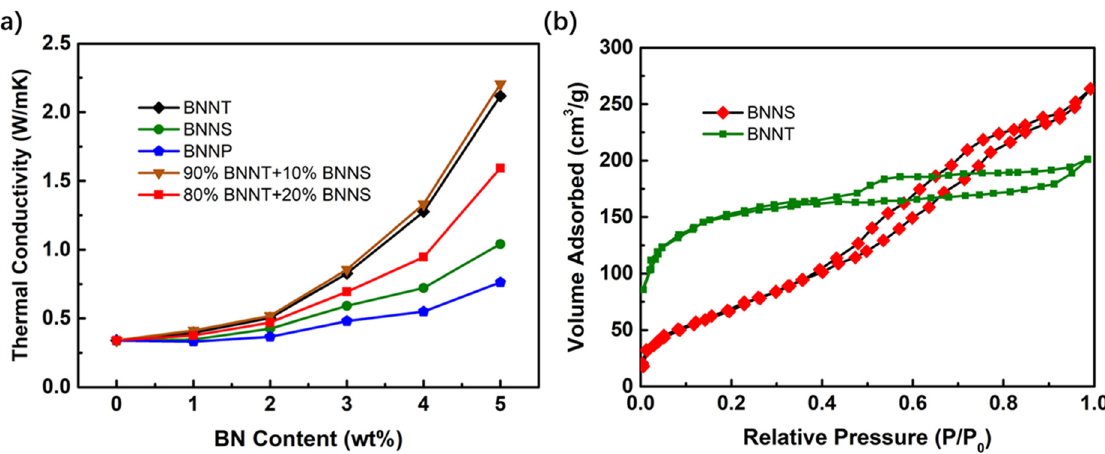
Figure 9. ( a )E ff ect of BN nanomaterials with di ff erent morphology on the thermal conductivity of PiG; ( b ) Nitrogen adsorption–desorption isotherm of BNNT and BNNS. PiG; ( b ) Nitrogen adsorption–desorption isotherm of BNNT and